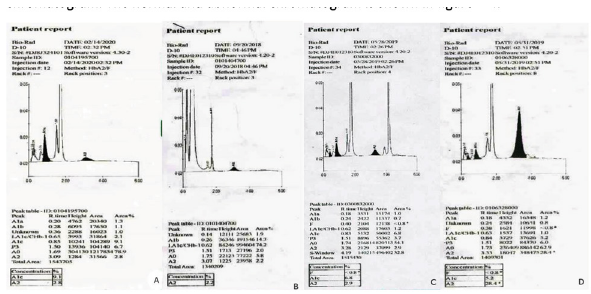
Figure 1: A) Normal Chromatogram, B) Beta-thalassemia